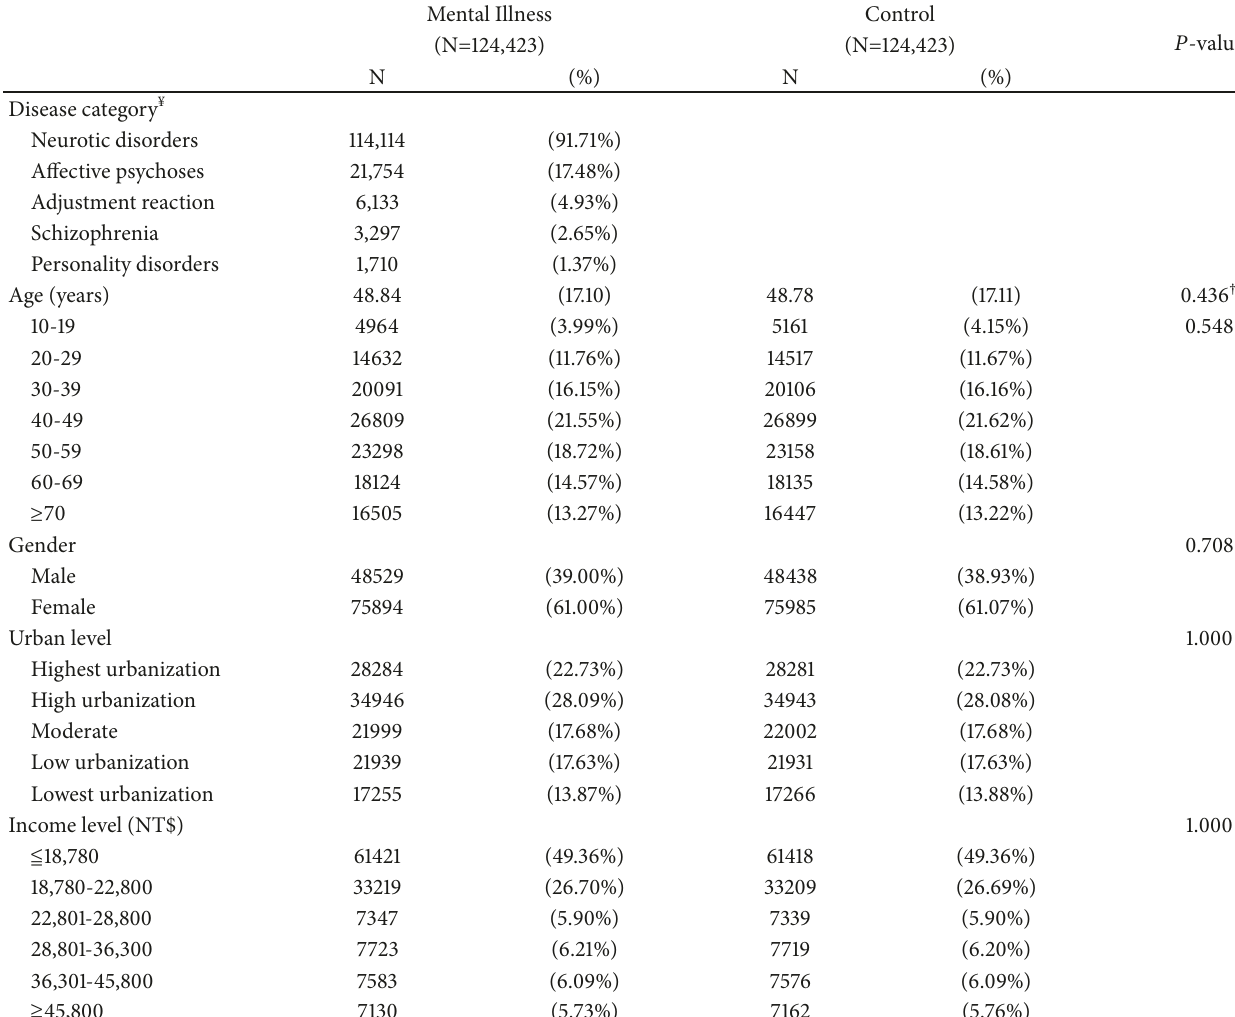
Table 1: The distribution of sociodemographiccharacteristicsbetween mental illness and controlcohorts and of the mentalillness atbaseline.